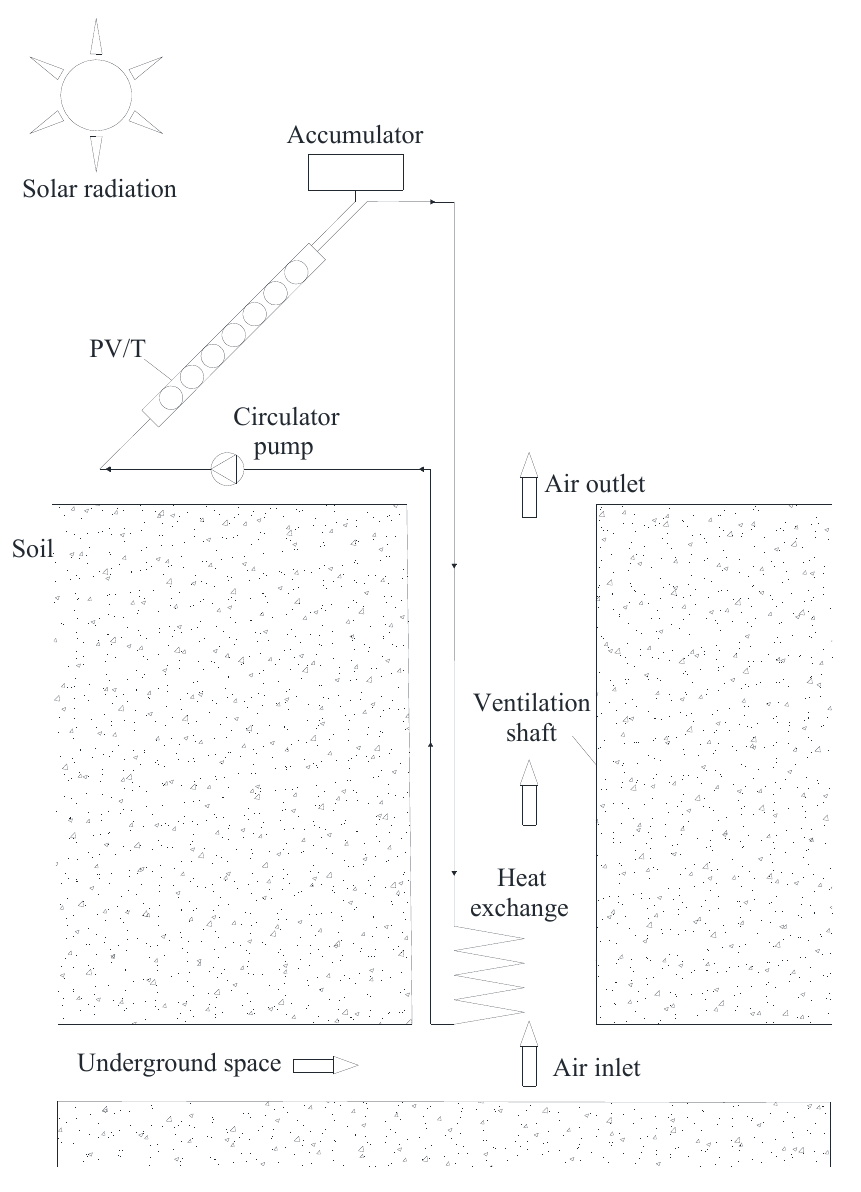
Figure 2. Ventilation system combining solar chimney effect and PV/T [118].